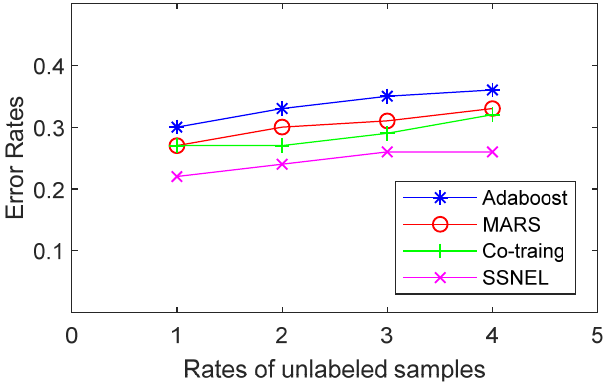
Figure 4. Error rates of the compared methods (wine).